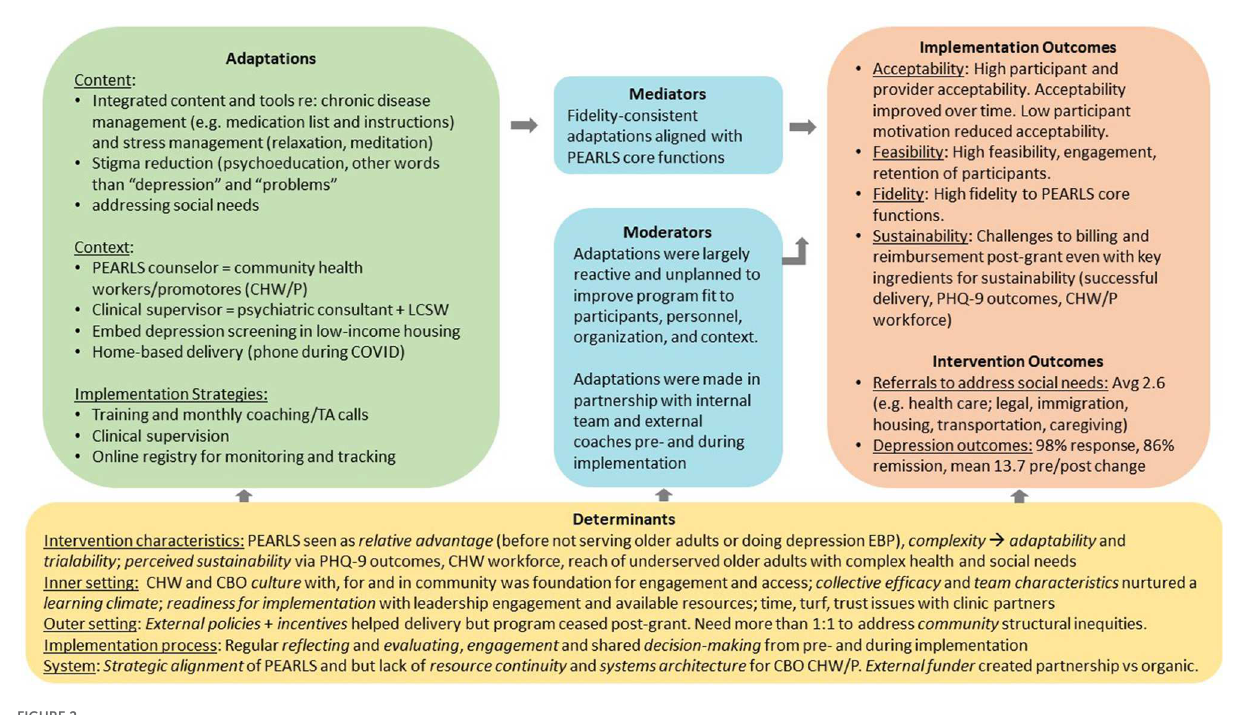
FIGURE2 PEARLS intervention (home-based collaborative care) with community health workers/promotores/promotores